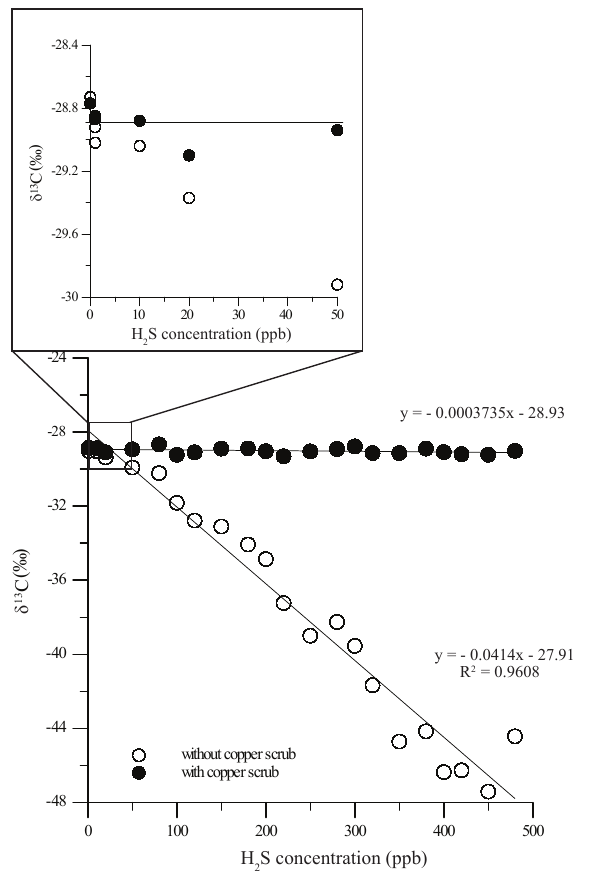
Figure 5. Isotopic signal from the Picarro G1101-i CRDS for 995ppm CO 2 with H 2 S concentrations ranging from 0 to 500ppb. Black dots represent isotopic measurements after H 2 S has been re- moved with copper; here the isotopic composition is maintained at the standard value ( − 28.5‰).